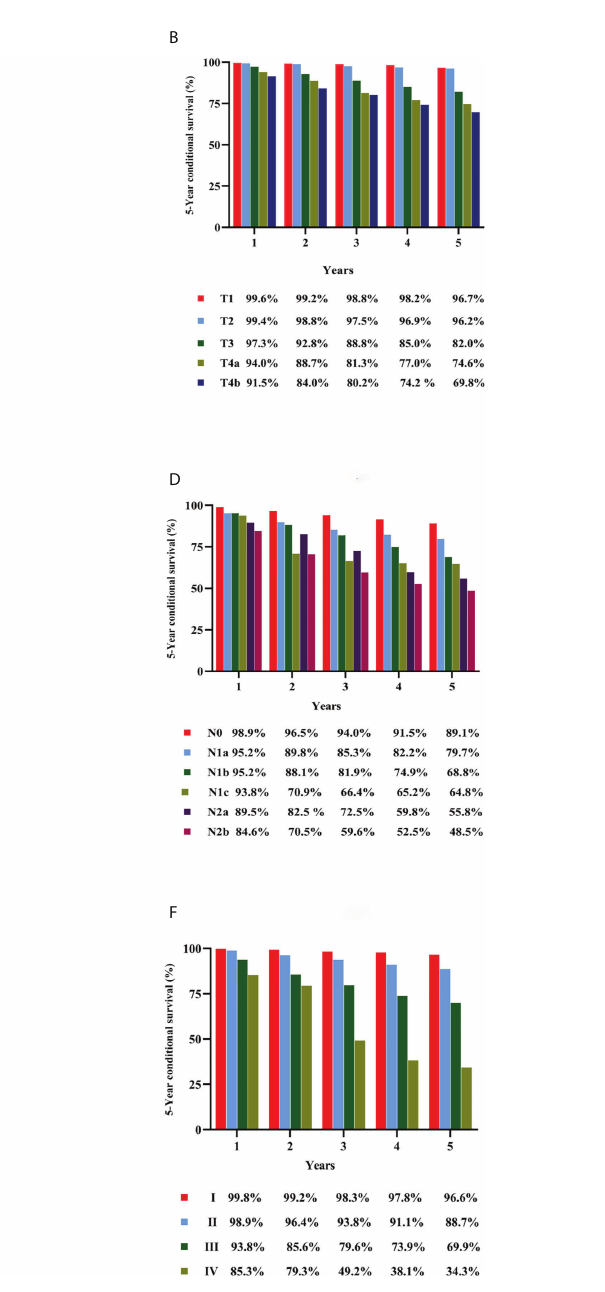
FIGURE 1 Kaplan – Meier curves for survival analysis in colon cancer patients. The OS according to T stage (A) , N stage (C) , and the TNM staging system (E) . The 5-year OS rates of the three classi fi cations [T stage, N stage, and TNM staging: (B, D, F) , respectively]. OS, overall survival; T, tumor; N, node; TNM,